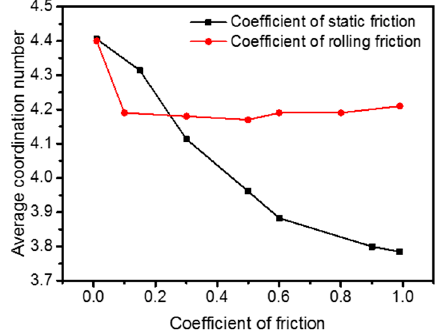
Figure 12. Frequency distribution of coordination number with different ( a ) static and ( b ) rolling friction coefficients.